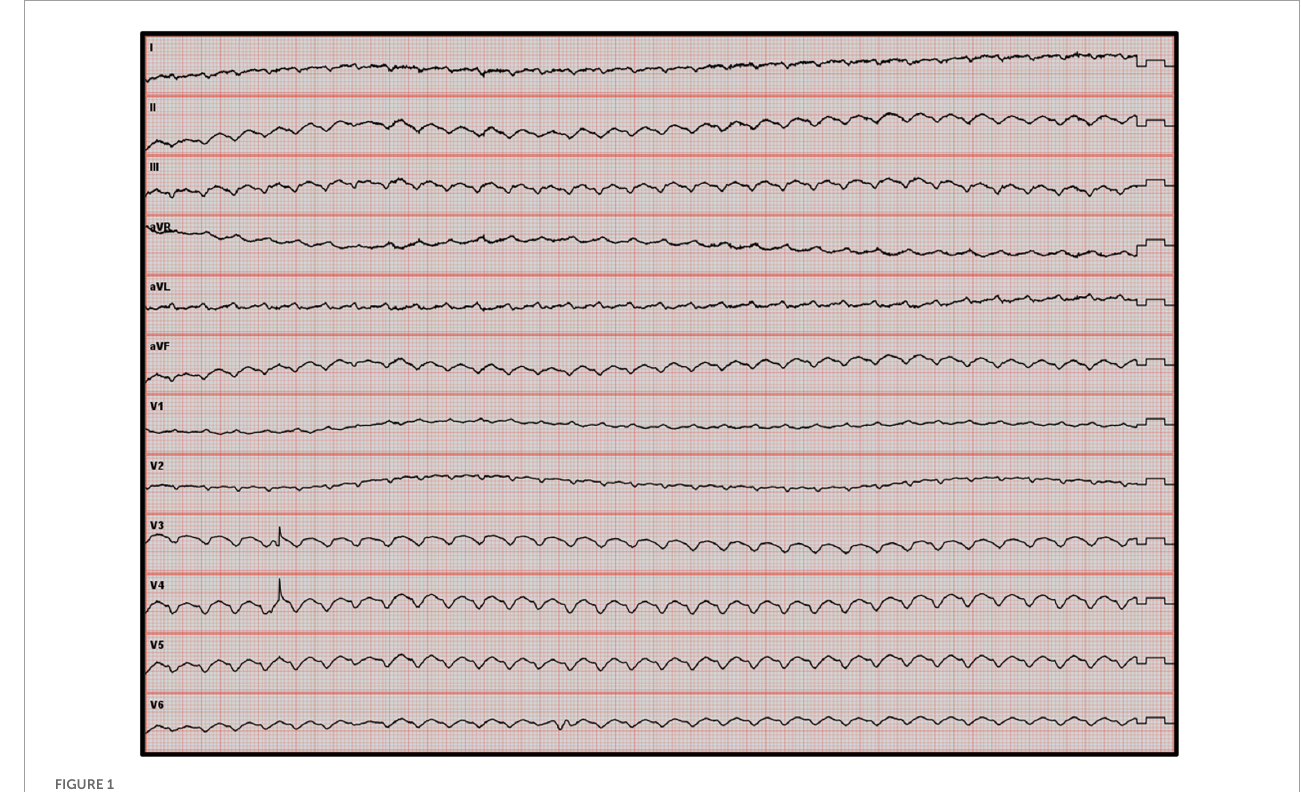
FIGURE1 Twelve-lead ECG showing a ventricular flutter. ECG, electrocardiogram.